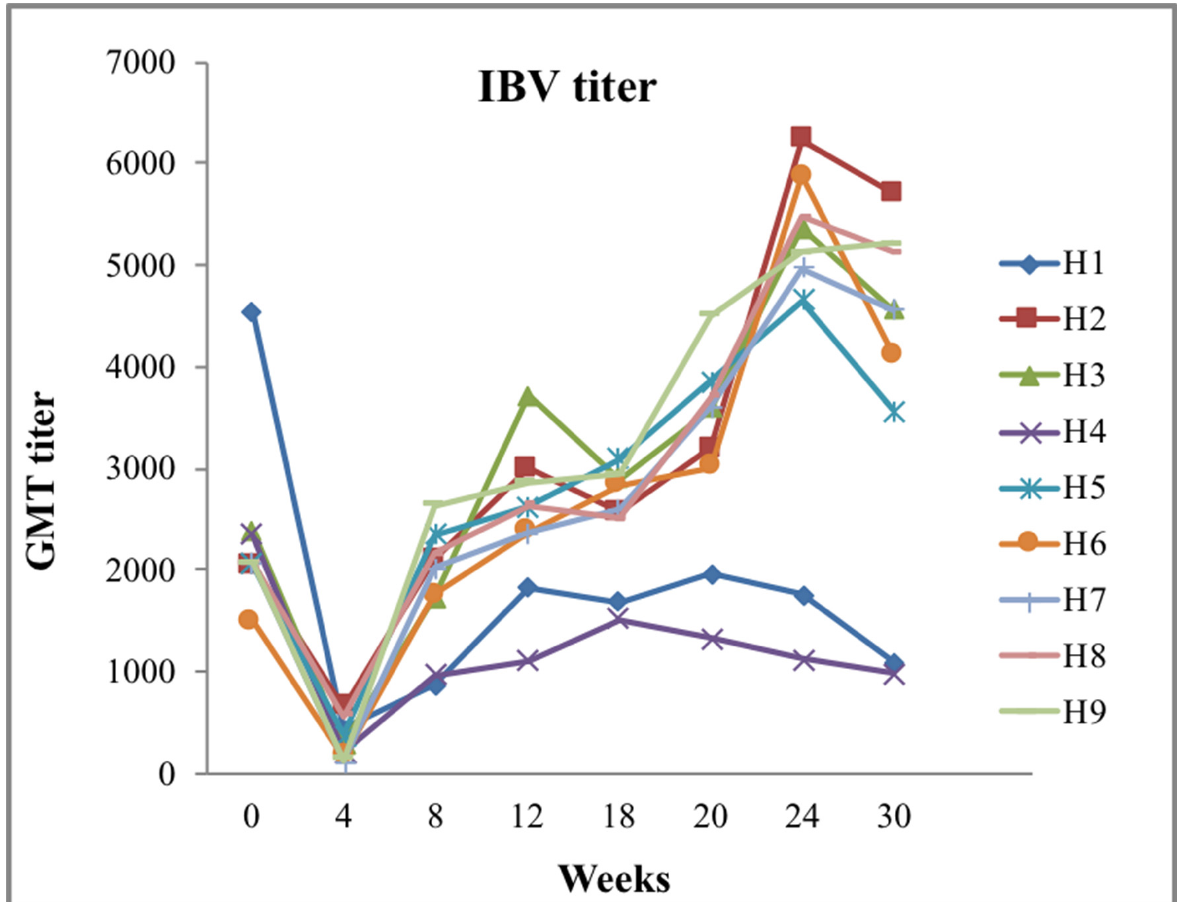
Figure 4. Geometric mean (IDEXX, USA) titer of nine broiler breeder houses in serology graph of 0–30 weeks. Birds vaccinated with infectious bronchitis (IB) live-attenuated vaccines followed by IBV variants and inactivated IBV-killed vaccination for 20 weeks during pullet stage. Out of 9 houses, House-1 and House-4 represent very low titer after vaccination compared with that of other houses. GMT titer was still below standard, indicating inappropriate vaccination with various involved factors during vaccination (X axis, weeks; Y axis, geometric mean titer (GMT)). (Source: personal communication; collected from Tuaran breeder farm, Sabah, Malaysia).